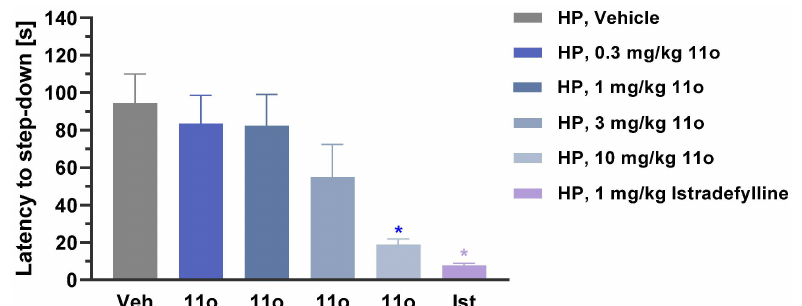
Figure 5. Latency to step-down in female rats injected with haloperidol (HP). Rats were administered with 11o (PO) 60 min before haloperidol injection at increasing dose levels. Istradefylline (1 mg/kg, PO) was used as positive control. The graph presents the mean latency (seconds) ± SEM ( n = 10 rats per group). Data were analyzed using the one-way ANOVA with Dunnett’s multiple comparisons test (all mean values were compared to vehicle). * p < 0.01.